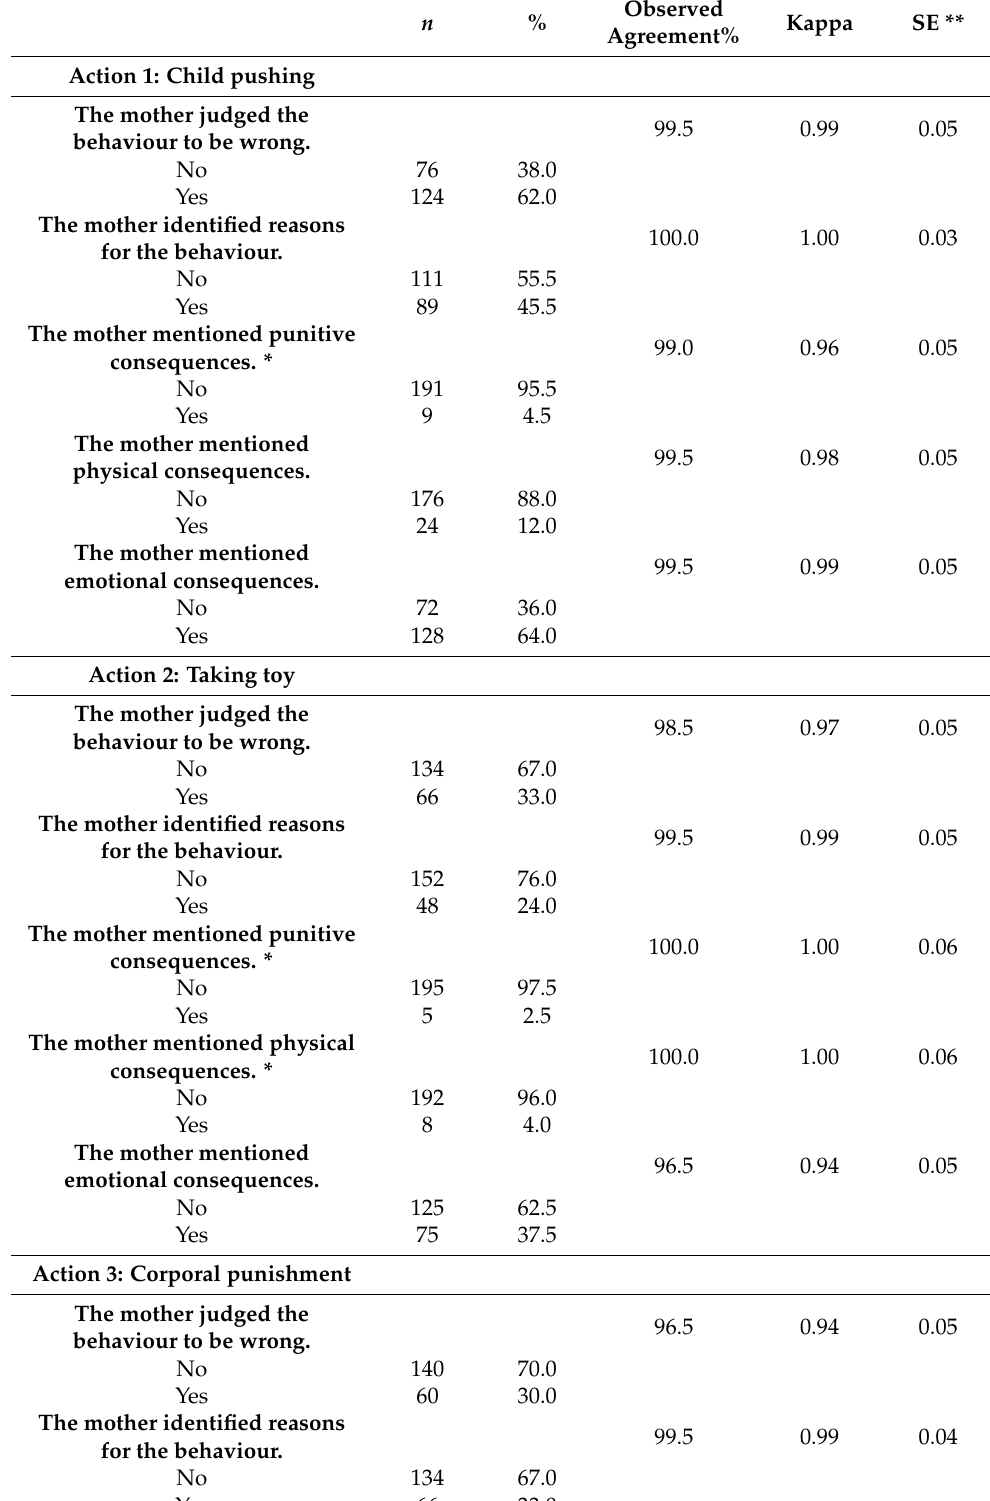
Table 3. Frequencies of communication items and kappa concordance statistics between coders. Pelotas, Brazil ( n =